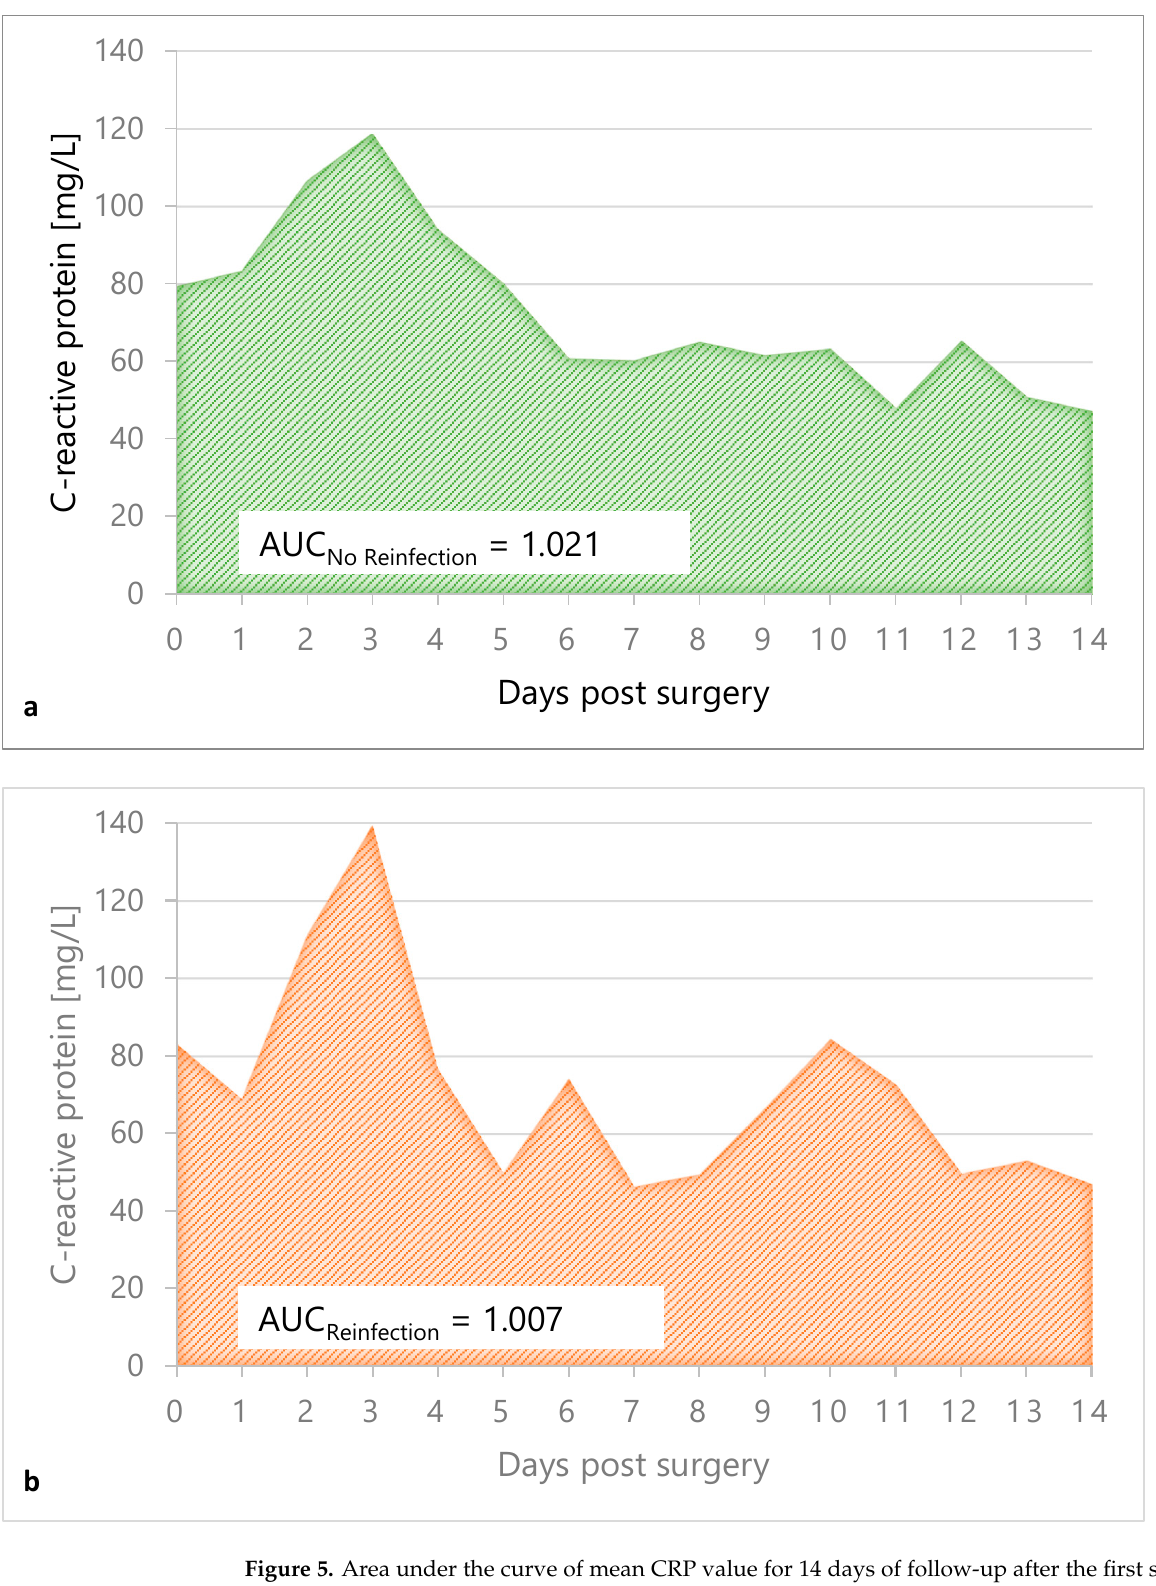
Figure 5. Area under the curve of mean CRP value for 14 days of follow-up after the first stage of TSR surgery of the “no reinfection” group ( a ), in green, and the “reinfection” group ( b ), in orange.